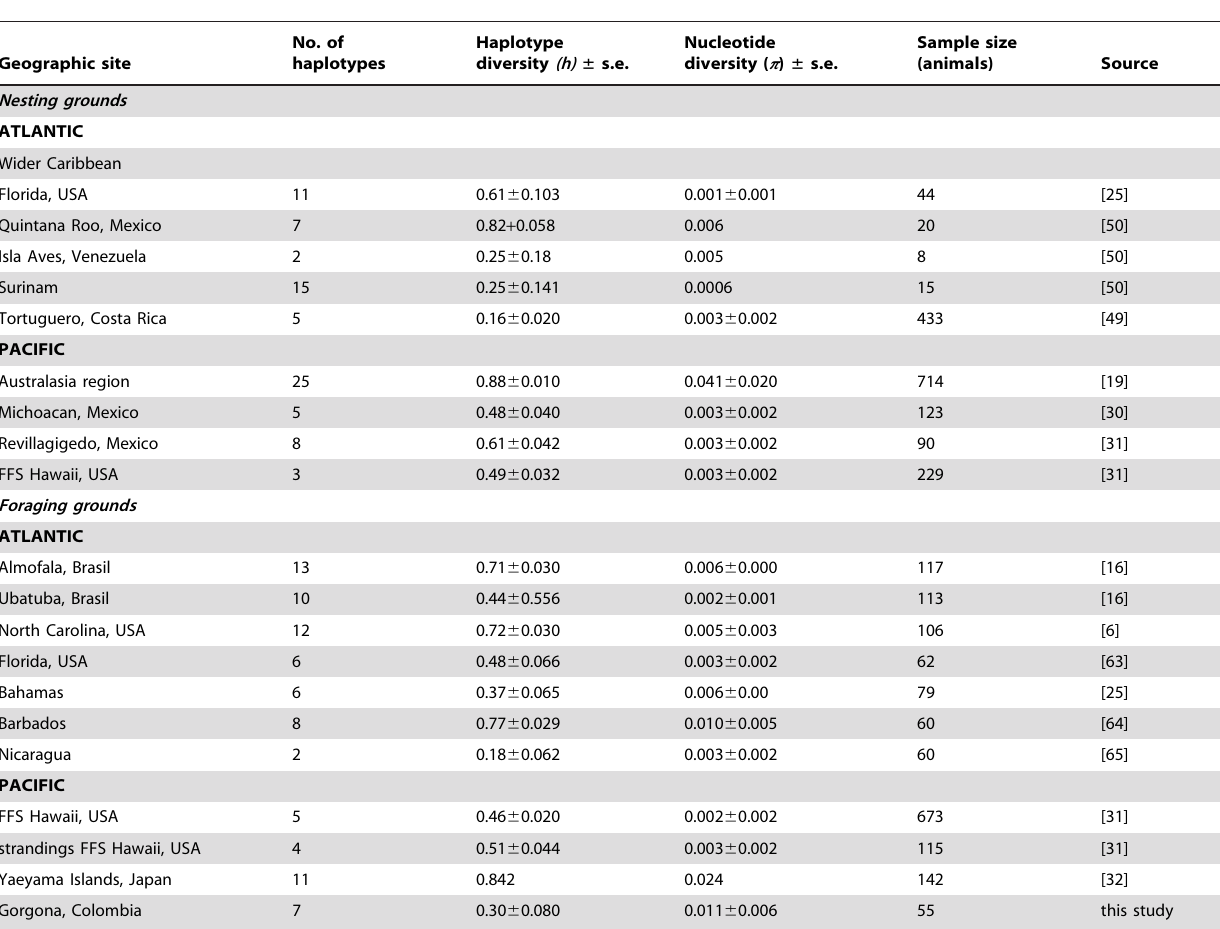
Table 2. Comparison of mtDNA control region sequence diversities in the Gorgona green turtle FG with the species’ published nesting and foraging aggregations, measured as haplotype diversity and nucleotide diversity.